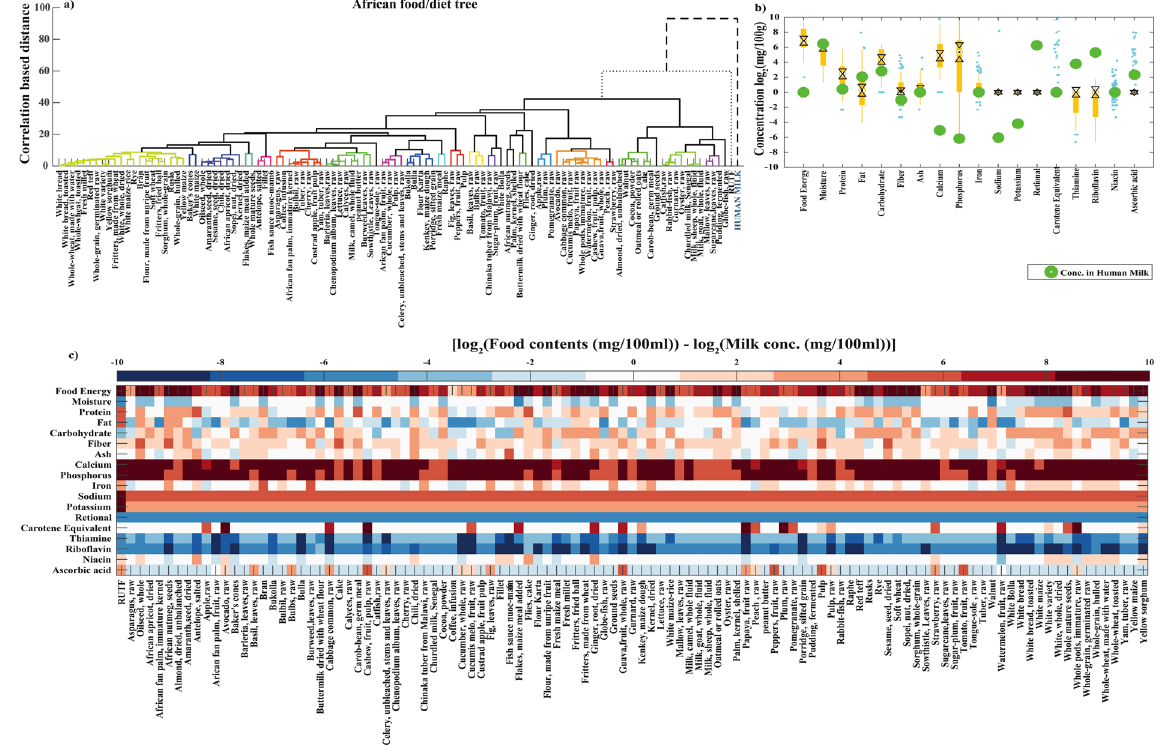
Figure 2. ( a ) Food tree of common and traditional African foods/diets. Each branch represent CBDM ( γ ) scaled between [0–100]. Cluster of similar foods with δ < 10 are color coded. Human milk or standard RUTF is represented as dotted lines. ( b ) Boxplot showing log of total dietary contents expressed in mg/100 g of foods. Black dot represents the median and cyan dots are the outliers. The concentration of the constituents available in human milk is marked with green